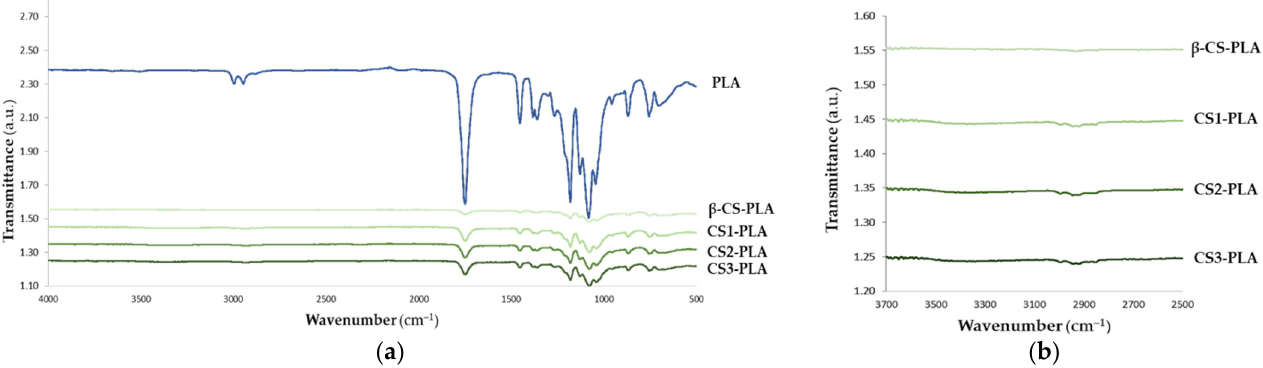
Figure 1. FTIR spectrum of ( a ) PLA and CS-PLA surfaces and ( b ) an inset graphic showing the characteristic bands of CS onto PLA films.